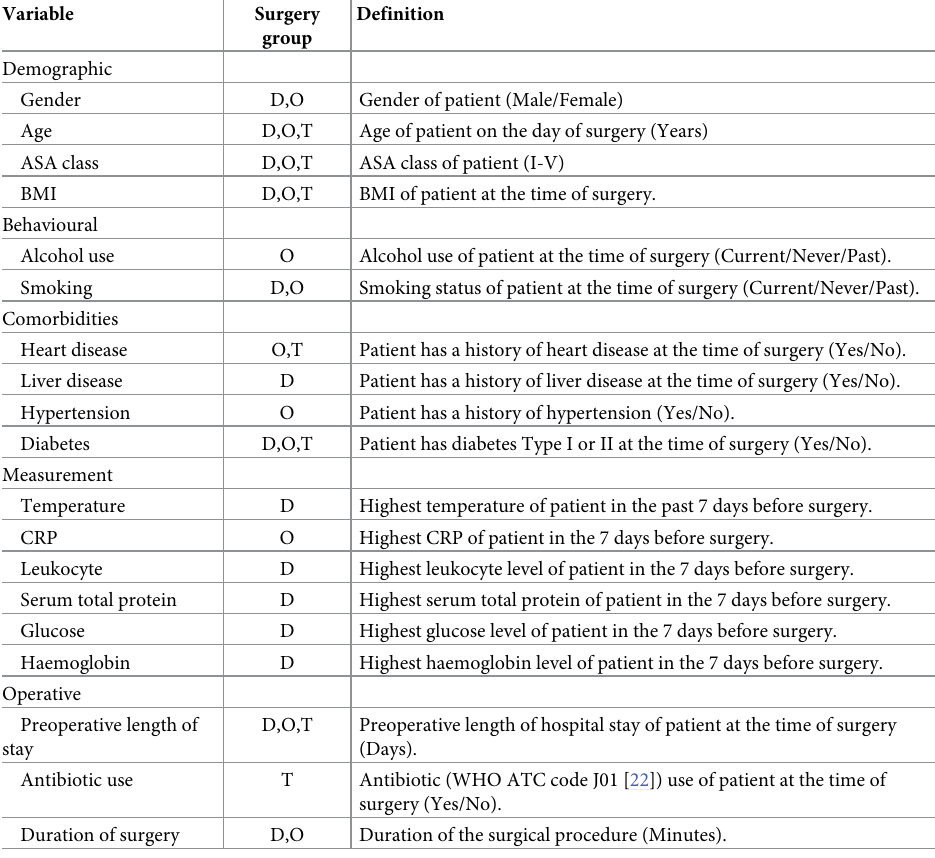
Table 1. Variable names and definitions used to investigate the occurrence of SSI in this